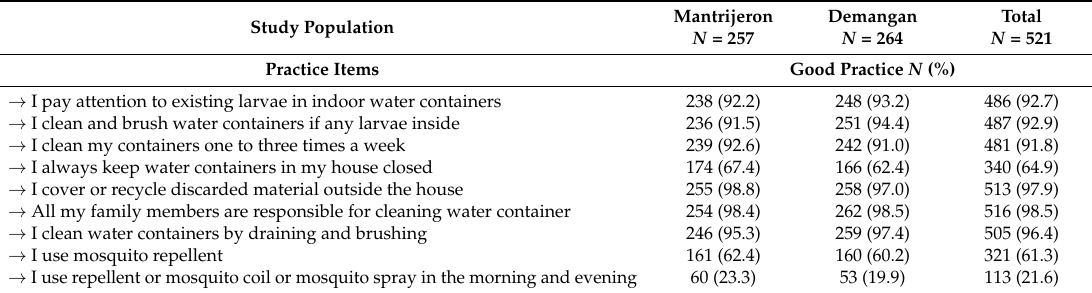
Table 4. Preventive measure regarding Dengue Fever